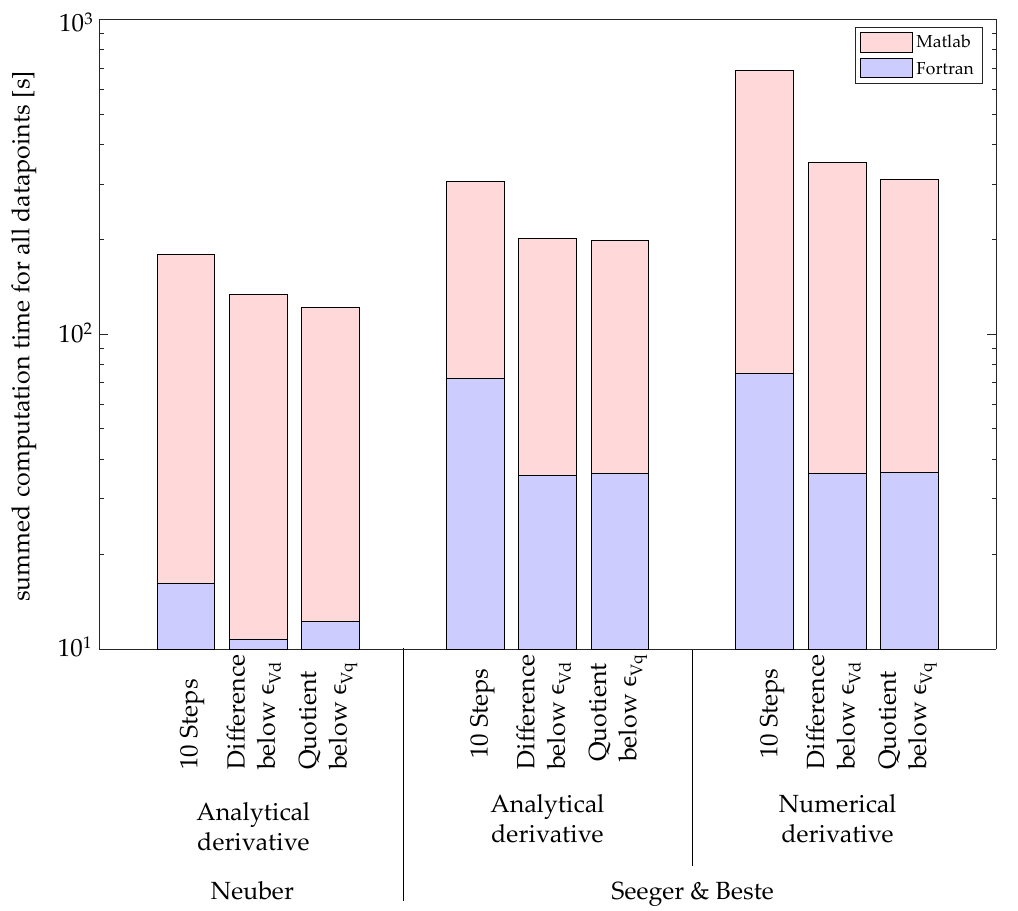
Figure 6. Summed calculation times for all 20,000,000 data points depending on the different formulations of the termination criteria for Newton’s method, the different formulations of the root finding problem and depending on the programming language (MATLAB and Fortran).